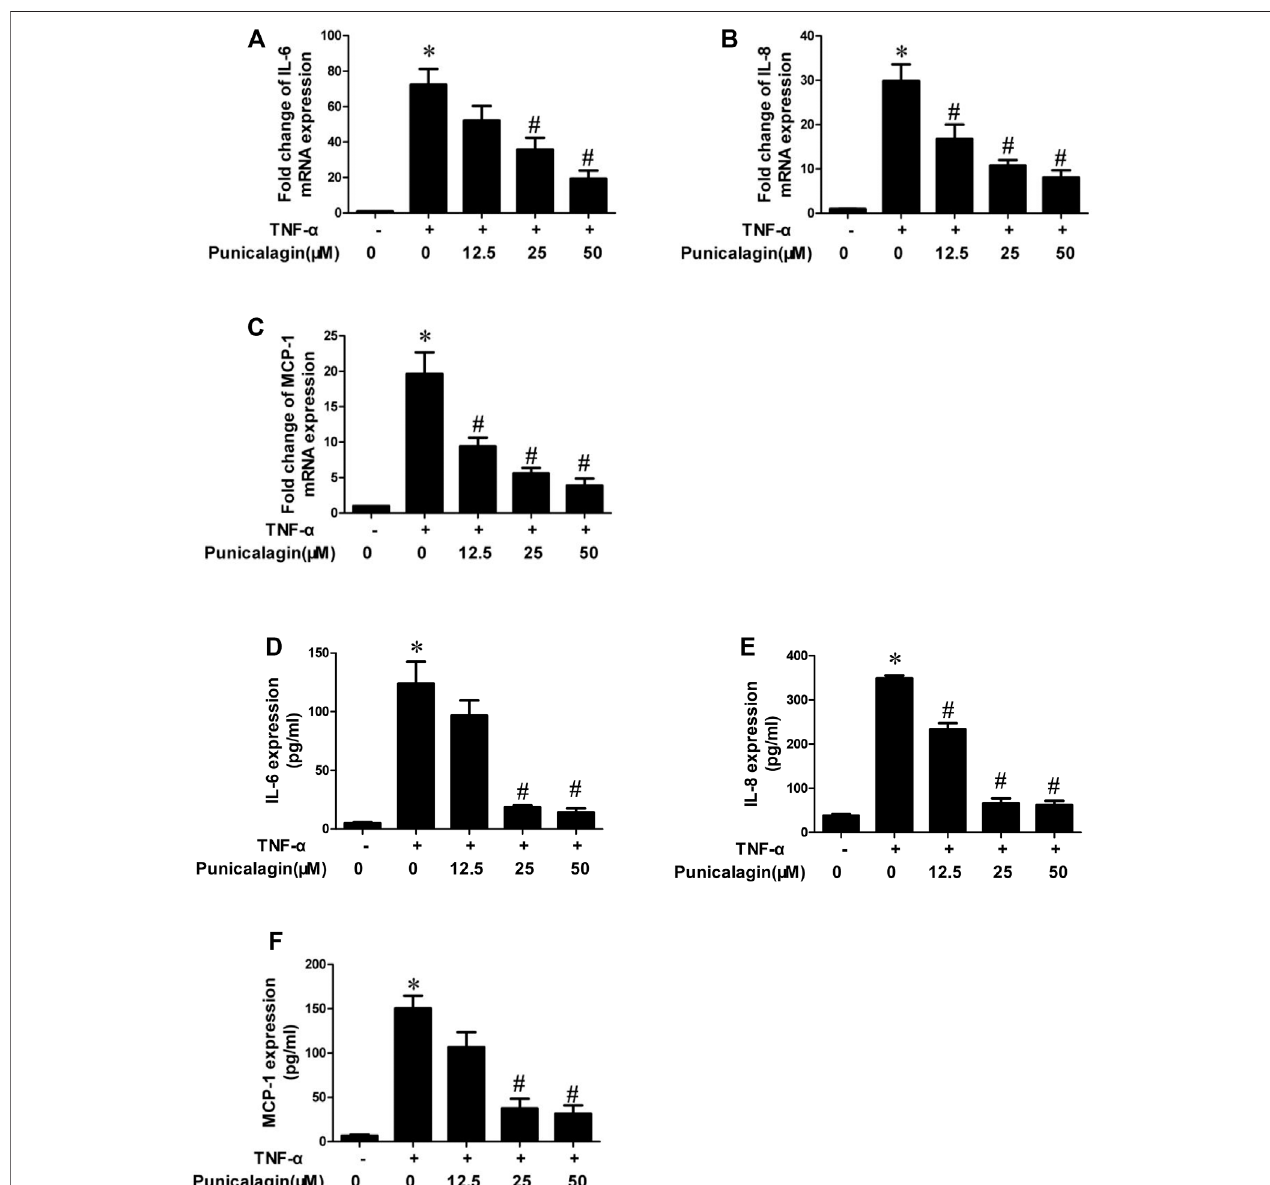
FIGURE4| InhibitionofpunicalaginonproductionofTNF- α -inducedpro-in fl ammatorycytokinesinHUVECs. (A – C) mRNAexpressionlevelsofpathogenicfactors related to in fl ammation in cells: IL-6, IL-8 and MCP-1. (D – F) Protein content in cell supernatant was detected by ELISA. * p < 0.05 vs. HUVECs without TNF- α , # p < 0.05 vs. groups treated with TNF- α